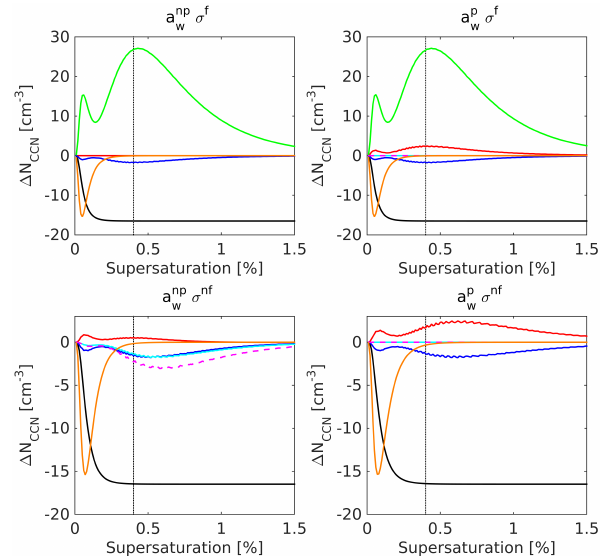
Figure 5. Sensitivity curves for marine average CCN concentrations as a function of supersaturation. Selected parameters are perturbed individually by 10% for all partitioning schemes; N 2 (black), ¯ r 2 (orange), α (red), ρ org (blue), σ (green), K (cyan), and (cid:48) (magenta). A vertical, grey dashed line is included at S a = 0 . 4% to indicate a regime change between stratiform and convective cloud